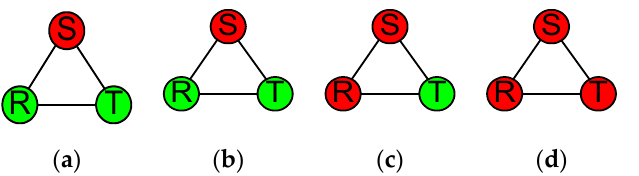
Figure 9. Hypothetical evolution of the pandemic. ( a ) Research at Duke University in 2005; ( b ) research transitions from US to France to the Wuhan Virology Institute (WVI) in China in 2013; ( c ) escape from the WVI in December 2019; ( d ) fully developed global pandemic in March, 2020.